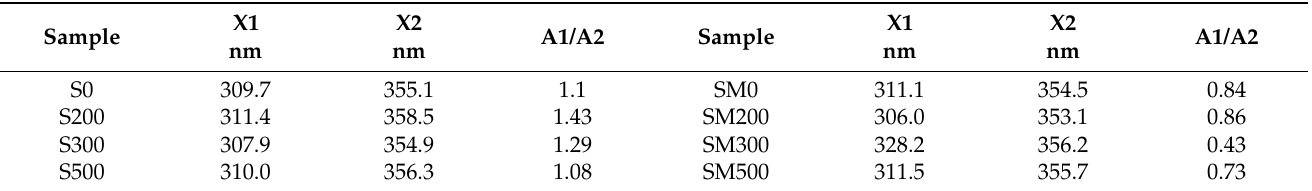
Table 4. Deconvolution parameters of PL spectra of CeF 3 micro- and nanopowder samples before and after annealing in air in a temperature range of 200–500 ◦ C.